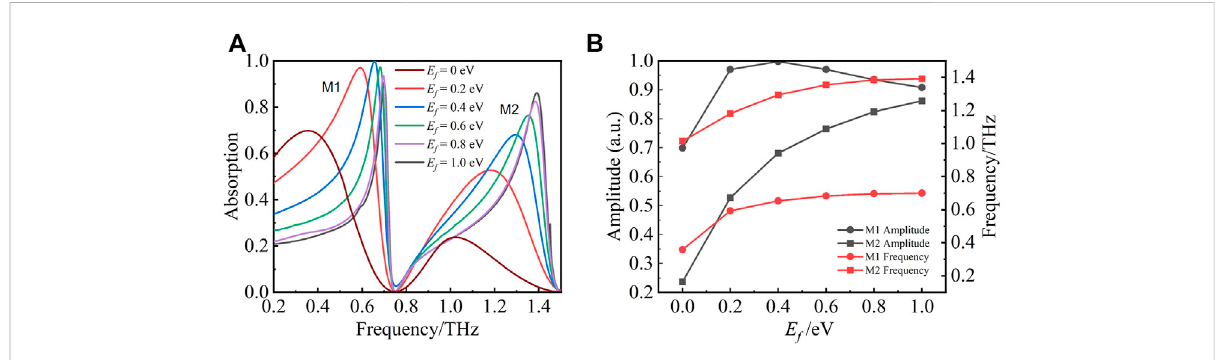
FIGURE 5 (A) TheabsorptionspectracorrespondingtotheFermilevel( E f )from0to1.0 eV. (B) Linegraphofmaximumabsorptionandresonantfrequency of absorption corresponding to the Fermi level ( E f ) from 0 to 1.0 eV.